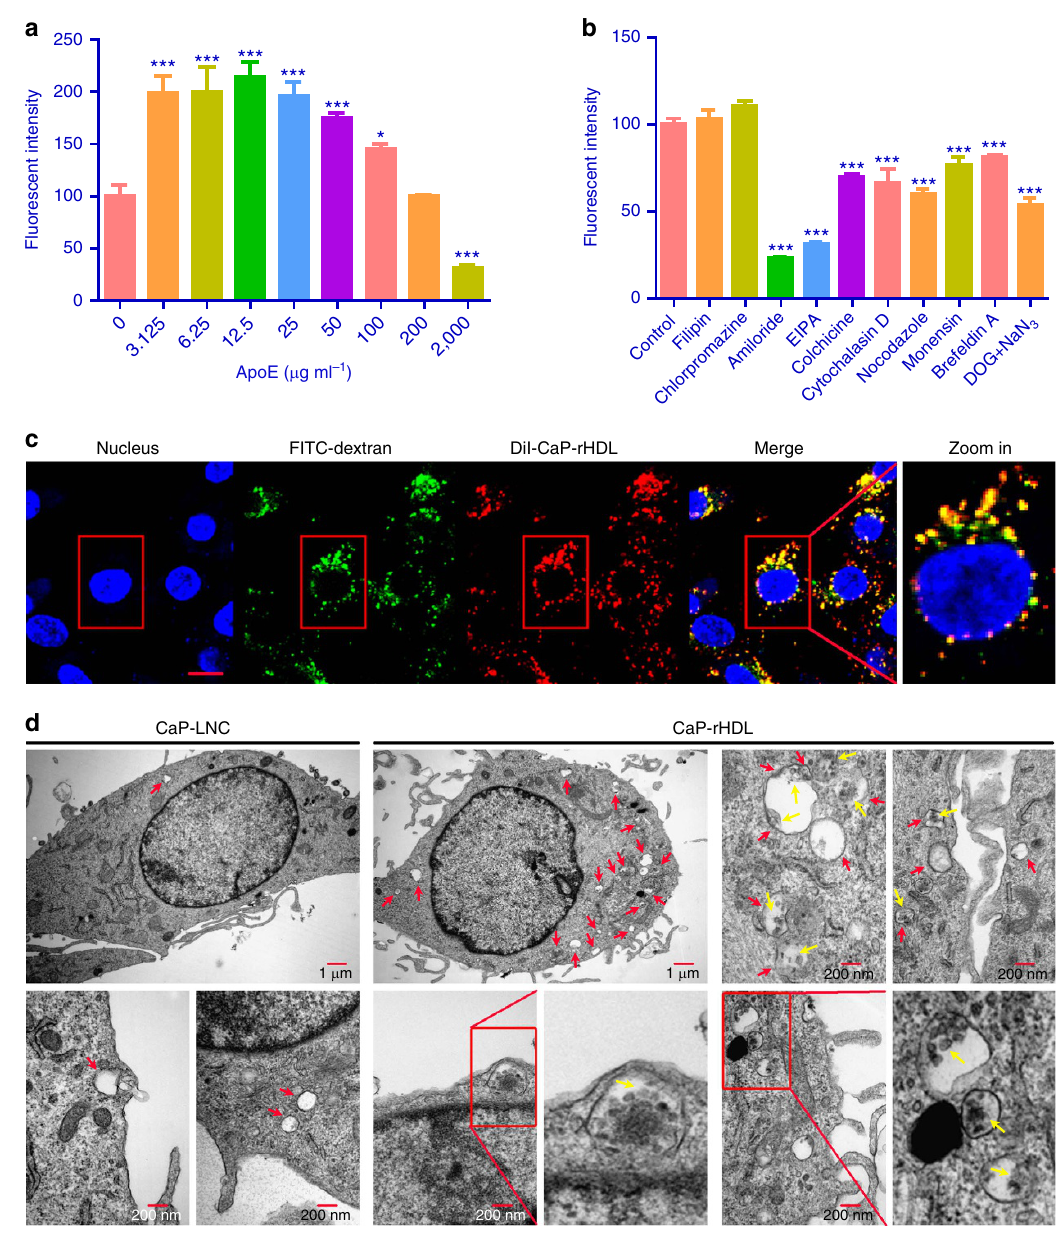
Figure 3 | Cellular uptake of CaP-rHDL in C6 glioblastoma cells via the macropinocytosis pathway. ( a ) Cellular association of DiI-CaP-rHDL in the presence of ApoE3 at the concentrations ranged from 0 m gml (cid:2) 1 to 2mgml (cid:2) 1 in C6 glioblastoma cells. ( b ) Cellular association of DiI-CaP-rHDL in the presence of different endocytosis inhibitors. For a and b , data represent mean ± s.d. ( n ¼ 3). *P o 0.05, ***P o 0.001 significantly different with that of the non-treated control. Two-tailed Student’s t -test was used for statistical analysis. ( c ) Colocalization of DiI-CaP-rHDL to macropinocytosis marker FITC- 70kDa dextran. Scale bar, 10 m m. ( d ) Macropinocytosis-mediated internalization of CaP-rHDL observed under TEM. C6 glioblastoma cells were incubated with CaP-LNC or CaP-rHDL for 3h, fixed and processed for observation under thin-section electron microscopy. Red arrows indicated macropinosomes. Yellow arrows indicated CaP-rHDL internalized via